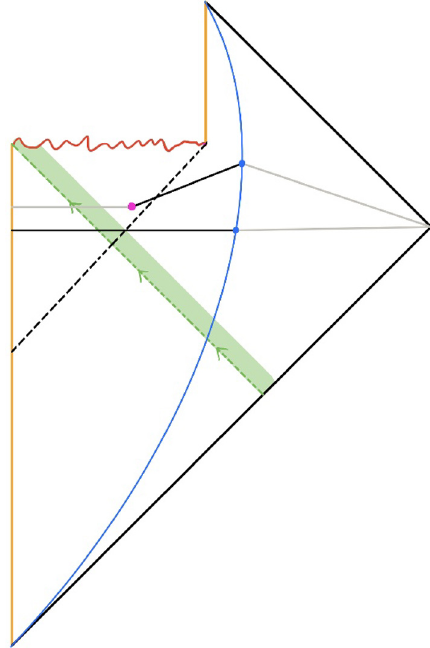
indicated, one before the Page time and the other after, corresponding to the no-island and island configurations,